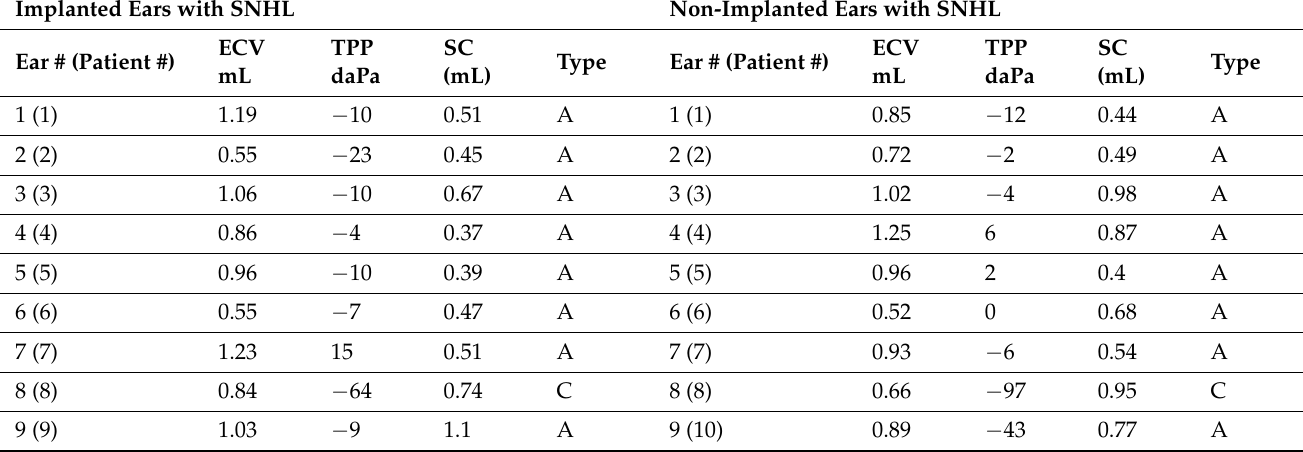
Table 2. Tympanometry values for the implanted and non-implanted ears.